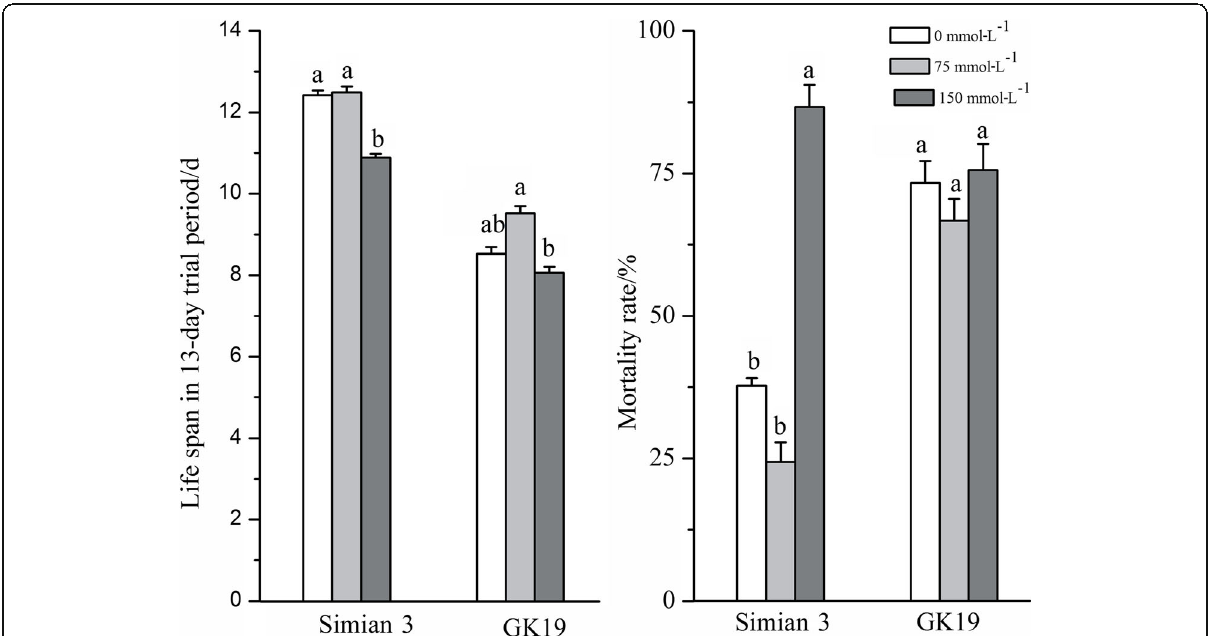
Fig. 5 Life span in a 1-day trial period and mortality rate of larvae fed leaves of GK19 and Simian 3 plants grown under NaCl stress. Mean ± (SE); Significant difference in lowercase letters at 0.05 level between NaCl stress